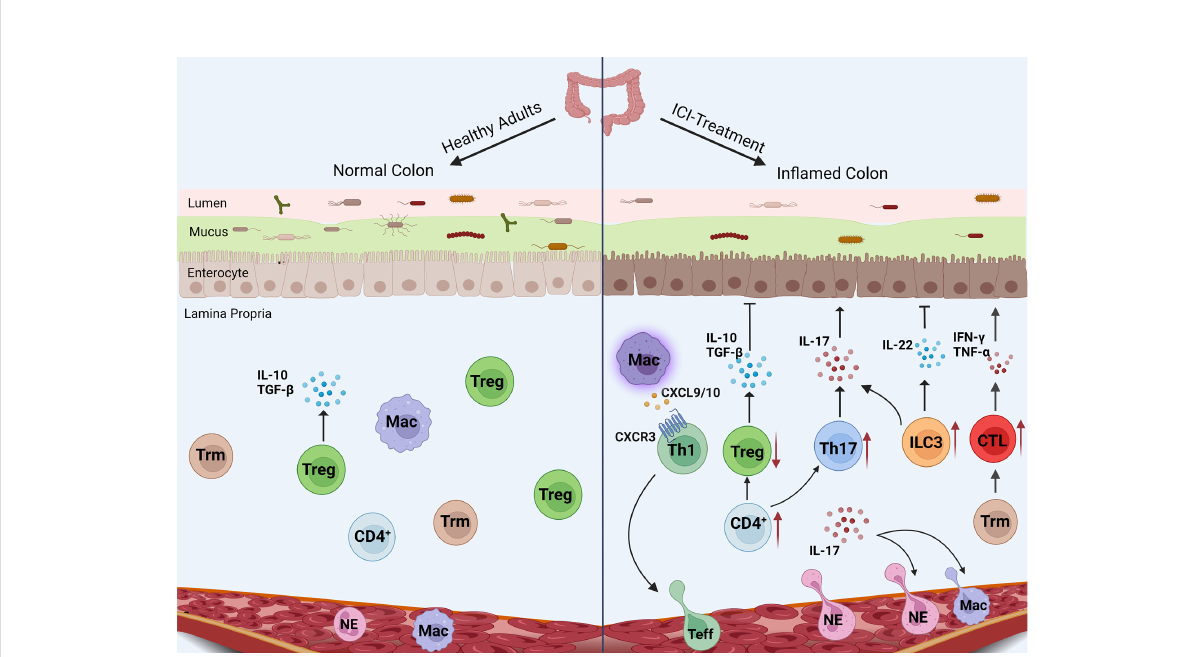
FIGURE 1 Mechanism of IMC. The pro-in fl ammatory pathways (CTL, Th17 cells, and neutrophils) enhance in IMC, while the anti-in fl ammatory pathways (Treg differentiation and IL-10 secretion) are inhibited. Macrophages recruit T cells through chemokines, and ILC3 plays an unknown role in